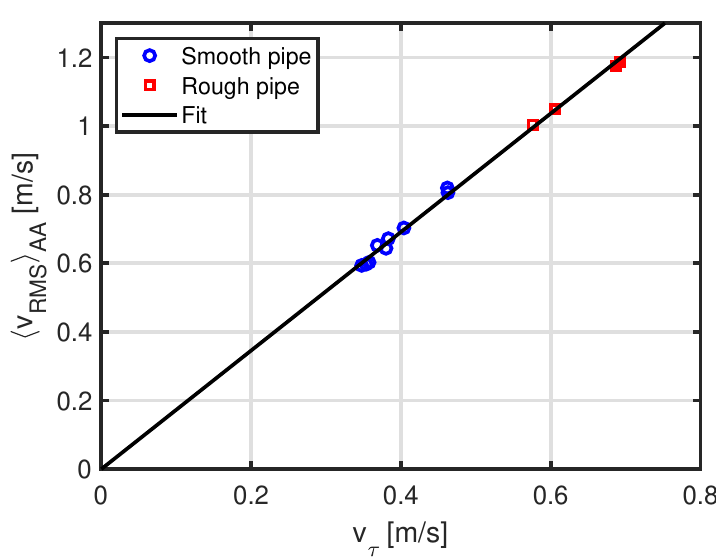
Figure 1. Relationship between v τ and (cid:104) v RMS (cid:105) AA